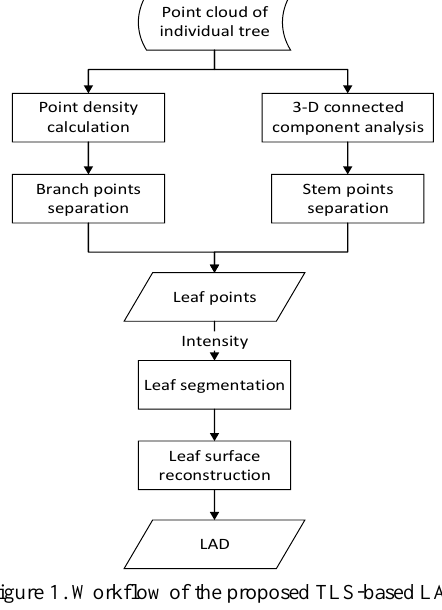
Figure 1. Workflow of the proposed TLS-based LAD extraction strategy